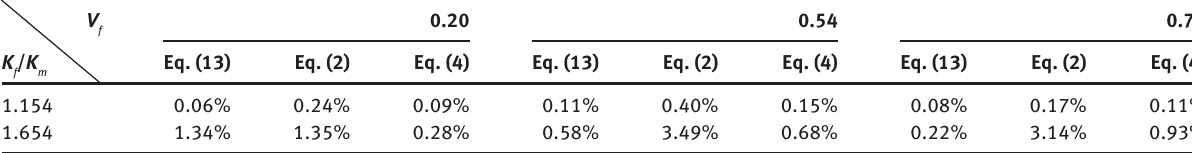
Table 3 Difference between CFD simulations and analytical predictions [Eqs. (2), (4), and (13)]. V f / K K f